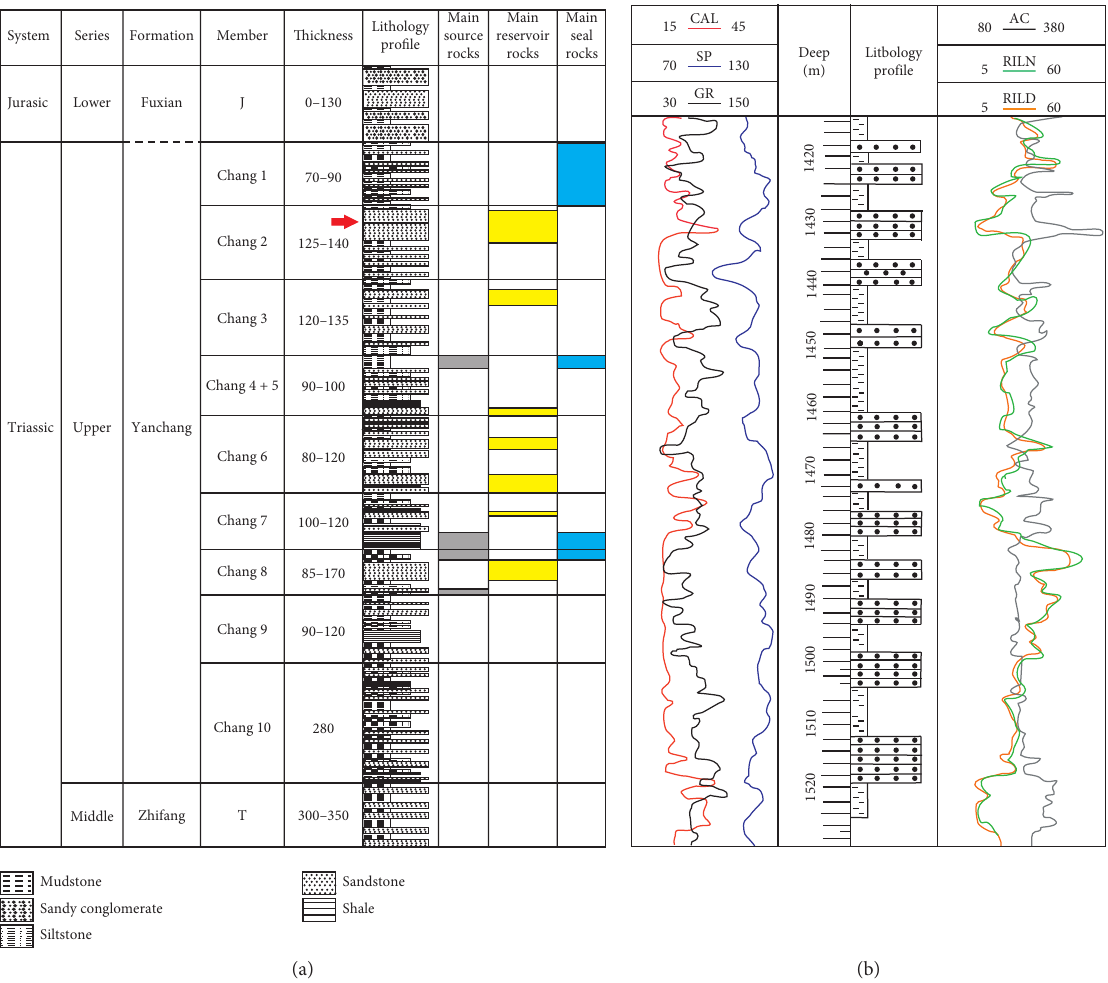
Figure 1: (a) Lithology profile of the Yanchang Formation and (b) well-logging data of Chang 2 reservoir in the study area